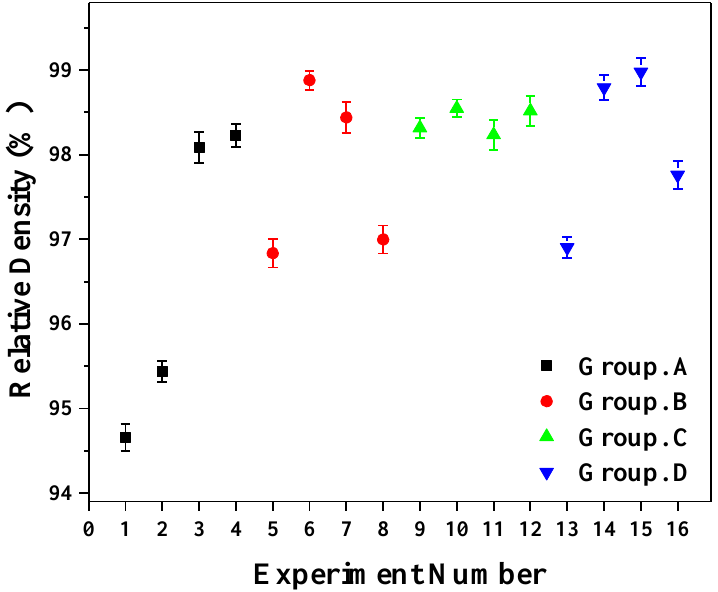
Figure 4. Relative density of samples fabricated by SLM with different process parameters. Figure 5 is the main effect diagram of alloy relative density under various process parameters obtained through orthogonal analysis. Figure 5a shows that when the laser power is increased from 160 W to 280 W, the compactness of the samples first shows a trend of increasing, then decreasing. When the laser power is too low, the energy absorbed by the powder becomes too low to be completely melted, the viscosity of the melt becomes higher and the fluidity becomes poor, resulting in poor lap quality between the melt channels and poor continuity of the melt channels. In addition, there are more irregular pores in the sample where the powder is not completely fused, resulting in a low relative density of the sample. When the laser power is 200 W, the sample relative density is significantly improved, as shown in Figure 6a,b. When the laser power rises to 280 W, the powder absorbs so much energy that the melt begins to evaporate. Fast expansion of vapor leads to explosions in the boiling melt [16]. The splashed particles adhere to the surface of the sample and cause a poor weld lap. Excessive laser power can cause spheroidisation and even burn. In addition, a large amount of molten metal evaporates, resulting in many circular pores on the surface of the sample, thereby reducing the relative density of the sample. When the laser power is high, the solidification time of the molten pool is prolonged, the hydrogen in the molten pool reaches the local solubility limit and nucleation generates bubbles. The bubbles diffuse from the bottom of the molten pool and the heat-affected zone to the top and eventually form many hydrogen holes, so the hole defects are obvious [17,18], as shown in Figure